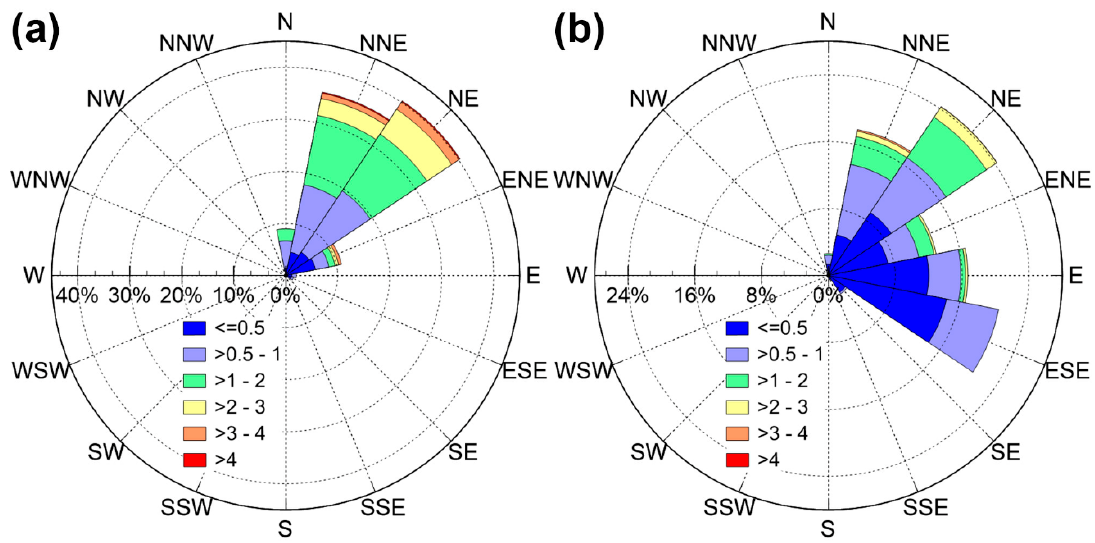
Figure 2. Rose diagram: ( a ) winter (December 2019–February 2020); ( b ) summer (June–August 2020).